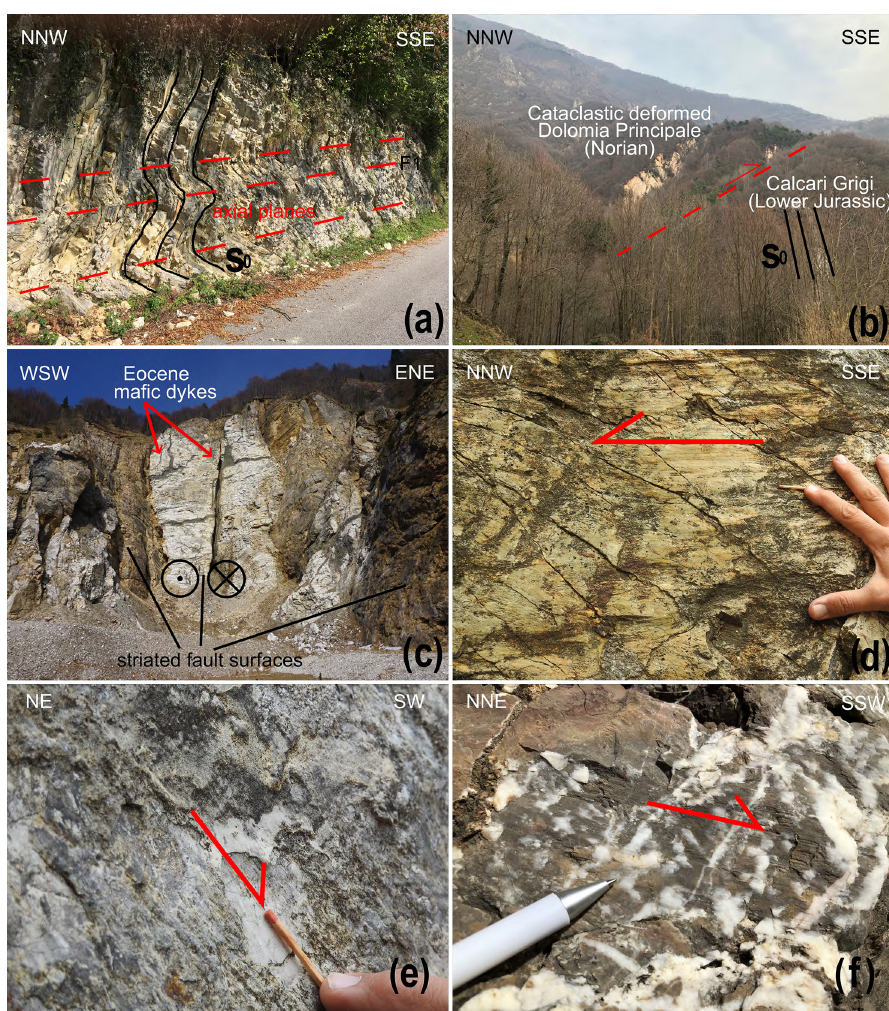
Figure 3. (a) Steepened Lower Cretaceous strata (Majolica), which are commonly found in the forelimb of the Monte Grappa ramp anticline forming the hanging wall of the blind Bassano Thrust. The dashed black lines indicate axial planes of chevron folds (formed due to flexural slip). (b) The Marana Thrust at Zanconati emplaces Norian Dolomia Principale on Lower Jurassic Calcari Grigi. (c) The Schio-Vicenza Fault at Passo della Borcola, offsetting Norian Dolomia Principale and Eocene mafic dykes. Striations on fault surfaces indicate oblique sinistral down-dip motion. (d) Older striations on the Borcola Pass Fault Zone (BPFZ; after Fondriest et al., 2012) indicating a sinistral sense of motion. (e) Younger striations on the BPFZ indicating oblique downthrow of the NE block of the BPFZ. (f) Dextral strike-slip slickenfibres at the eastern end of the hanging wall of the Valsugana Fault (near Pieve di Cadore) where the Valsugana Fault branches into several fault splays and becomes transpressive. The uninterpreted field photographs can be found in Verwater et al.